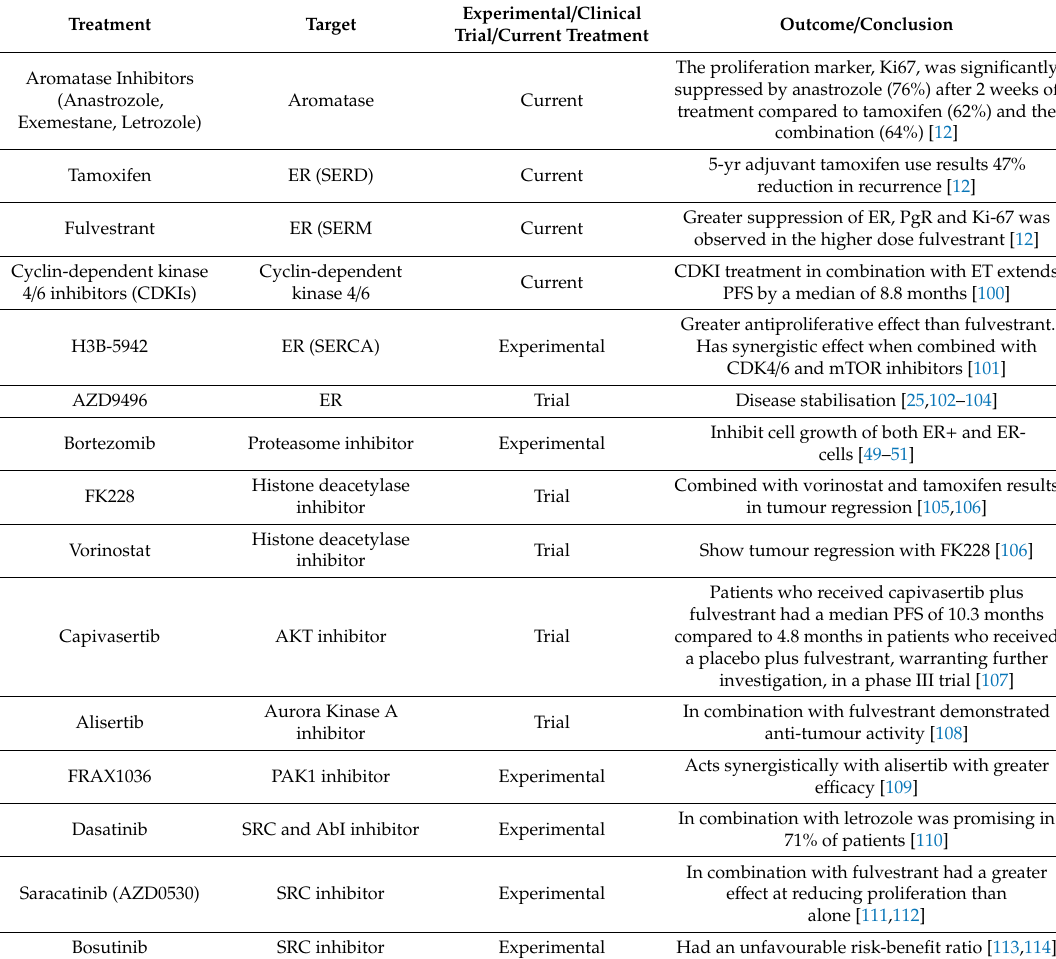
Table 2. Current and Potential Therapeutic Targets in Breast